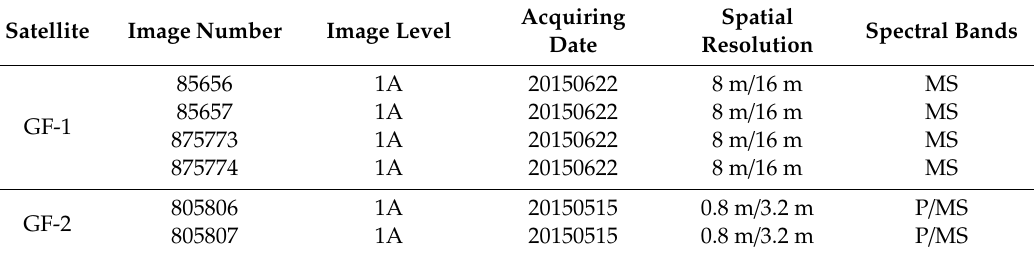
Table 2. Data used in this